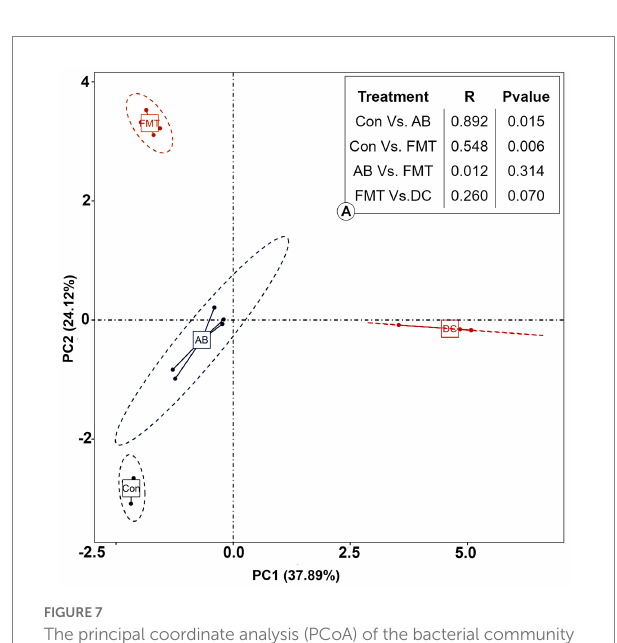
FIGURE 7 The principal coordinate analysis (PCoA) of the bacterial community structures of mice and donor gut microbiomes based on the Bray- Curtis (weighted UniFrac) distance. (A): The analysis of similarity (ANOSIM) of the four groups. Con, Control group; FMT, fecal microbiota transplantation group; AB, antibiotic group; DC, donor